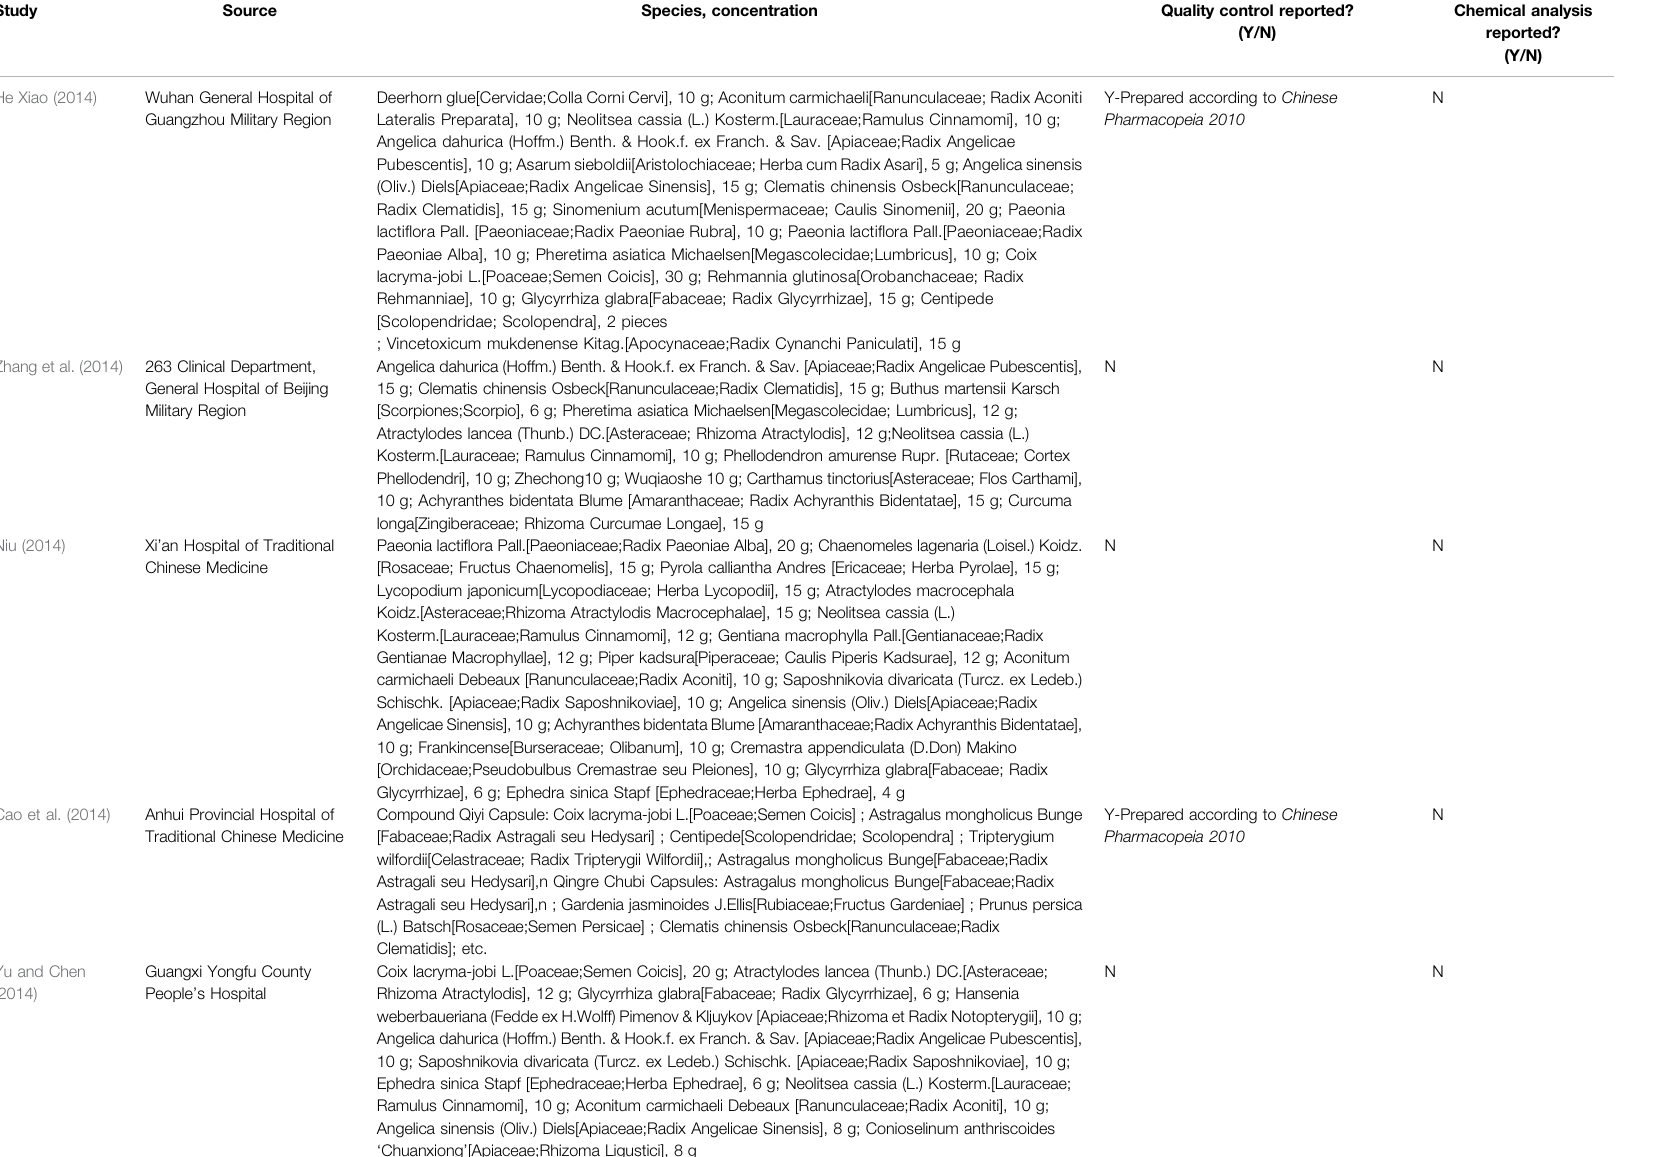
TABLE 2 | ( Continued ) A summary table describing the composition of the